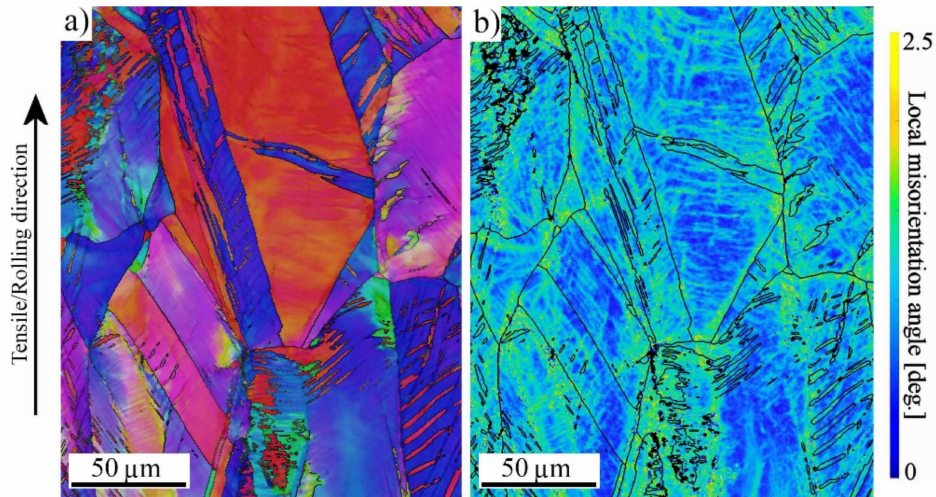
Figure 7. ( a ) IPF and ( b ) KAM maps of wrought 316L, strained at the higher strain rate. Twinning is present mainly in [111]-orientated